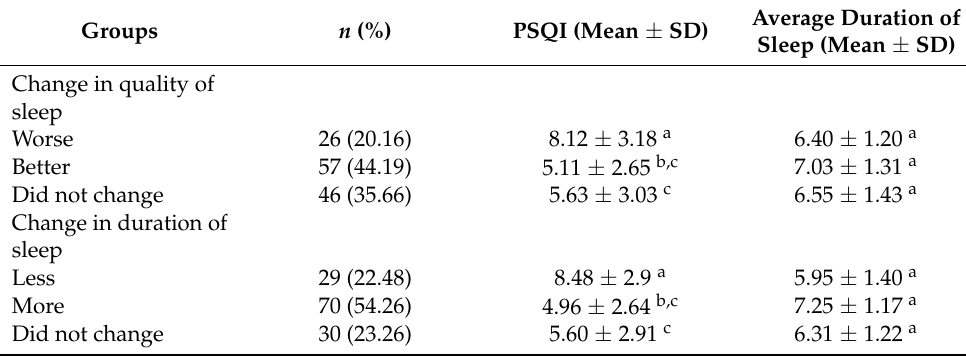
Table 5. PSQI, average sleep duration, average sleep quality and financial